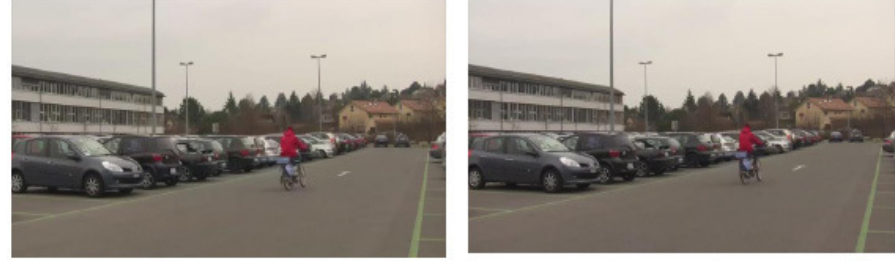
Figure 6. Different error scenarios induced in left views of 3D Video